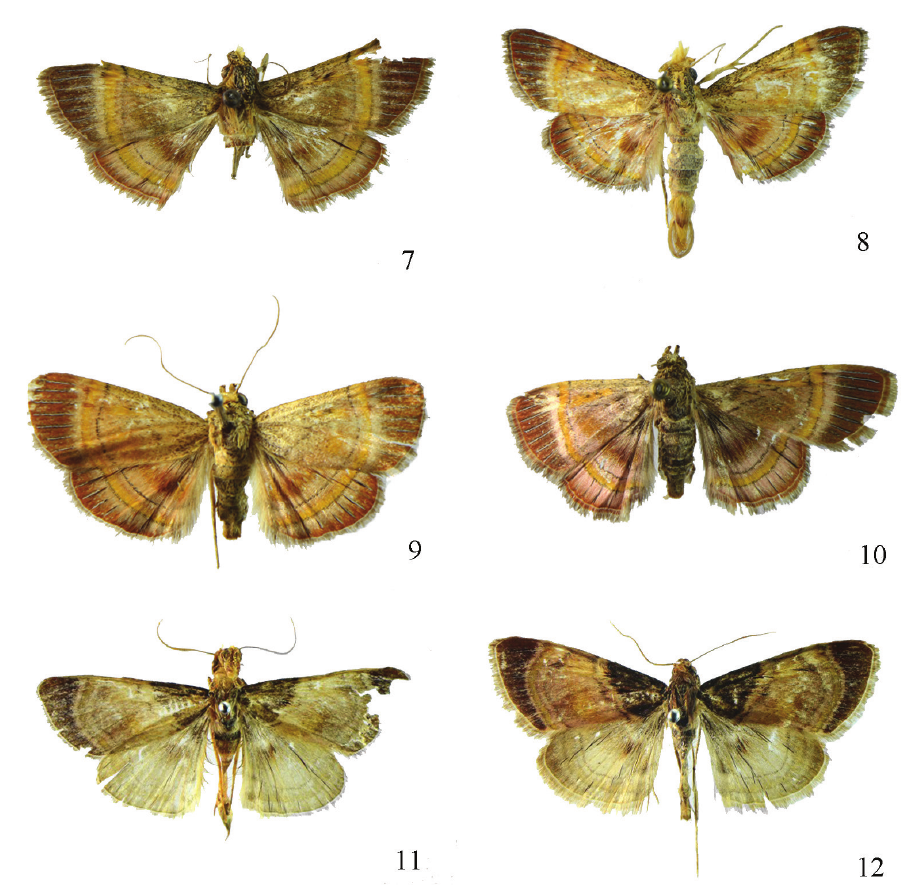
Figures 7–12. Adults. 7 Lista menghaiensis sp. n., male, holotype 8 L. plinthochroa (West, 1931), male 9 L. plinthochroa (West, 1931), female 10 L. sichuanensis sp. n., female, paratype 11 L. variegata (Moore, 1888), male 12 L. variegata (Moore, 1888), female. Lista plinthochroa (West, 1931) Figs 8–9, 20, 30 Stericta plinthochroa West, 1931: 210. Lista plinthochroa (West): Solis 1992: 283. Diagnosis. This species is significantly different from others by the end of the abdo- men with long hair-like scales. In the male genitalia, the valva broadens from the base to the outer margin and the sclerotized plate on the valva extends toward outer margin. Material examined. Sichuan: Emeishan, 3 ♂♂ 16 ♀♀ , 800–1000m, 6.V–30.VI.1957, Zhu Fuxing & Huang Keren (gen. slide no. Ep11, Ep518, Ep525, Ep6–1, Ep572); Emeishan, 1 ♀ , 9.VI.1979, Gao Ping; Qinchengshan, 1 ♂ , 700–1600m, 30.V.1979